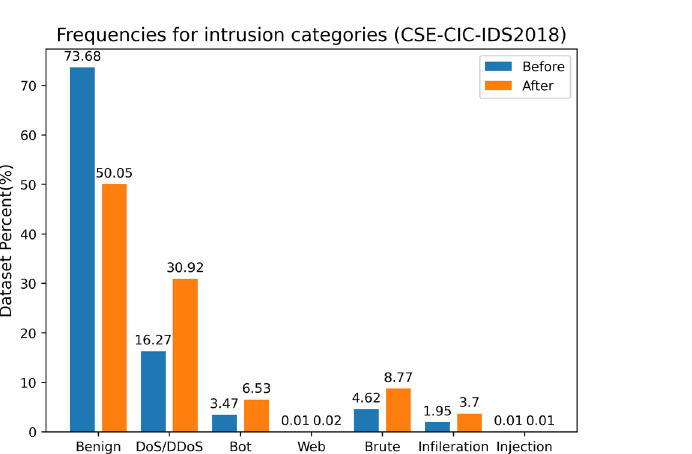
Figure 1. ID-RDRL Model schematic.